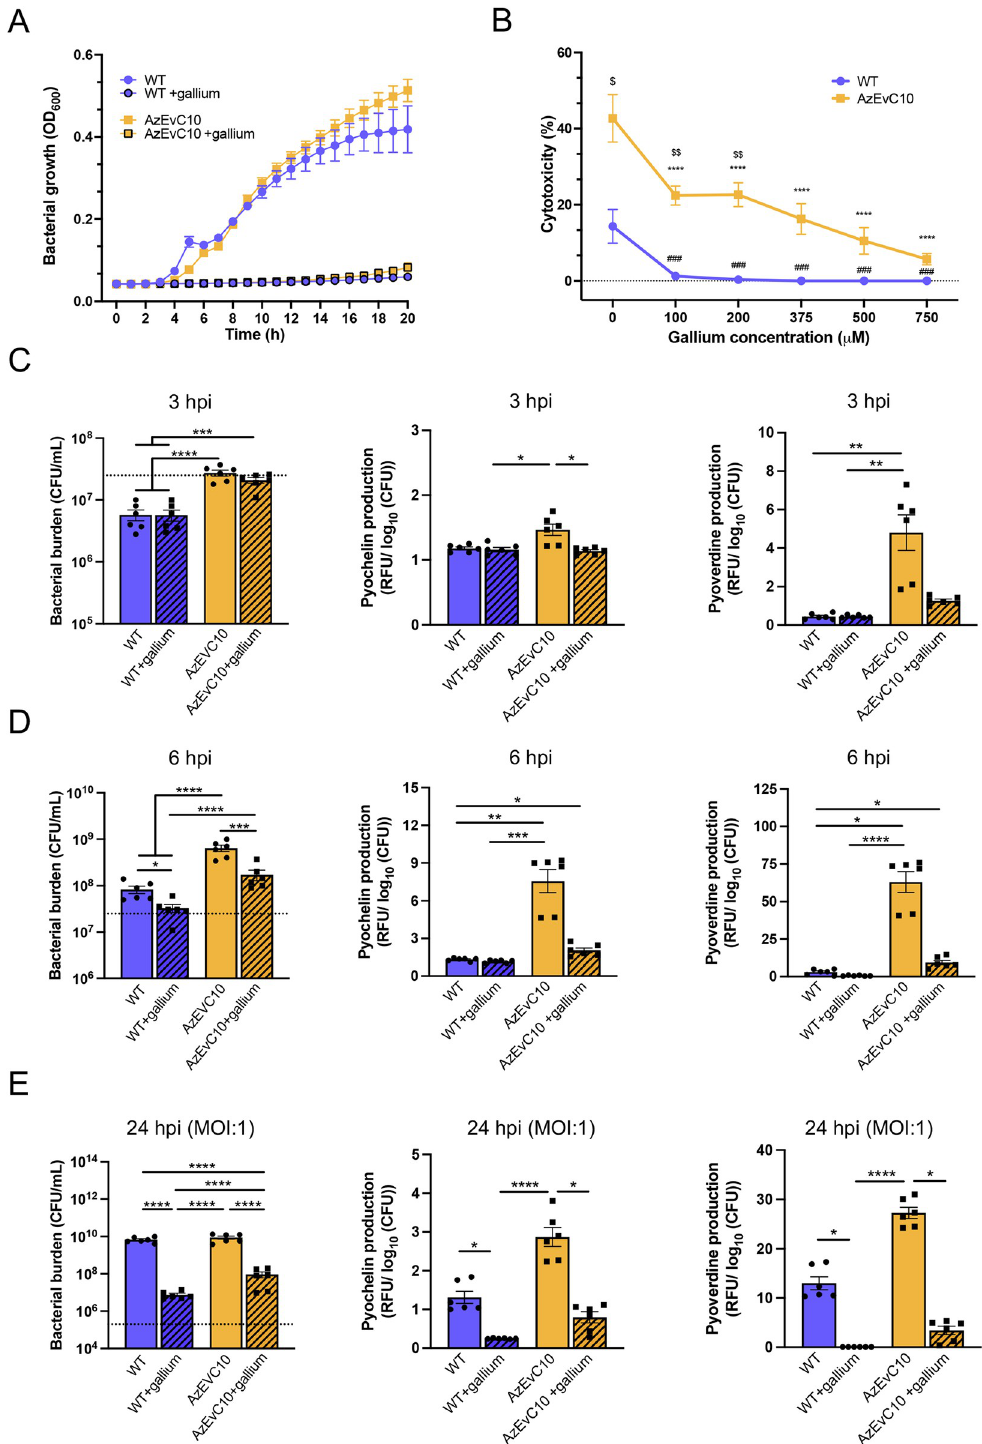
Fig 6. Gallium efficiently inhibits AzEvC10 siderophore production and proliferation during macrophage infection. A. WT PAO1 and AzEvC10 mutant growth curves in LB broth in the presence or absence of 150 μ M gallium. B. BMDM were infected with either WT PAO1 or the AzEvC10 mutant (MOI:100) and treated with different concentrations of gallium for 6 h. BMDM cytotoxicity assessed by LDH assay: #represents the comparisons between WT with gallium to the WT no gallium baseline; * represents the comparisons between AzEvC10 with gallium to AzEvC10 no gallium baseline;